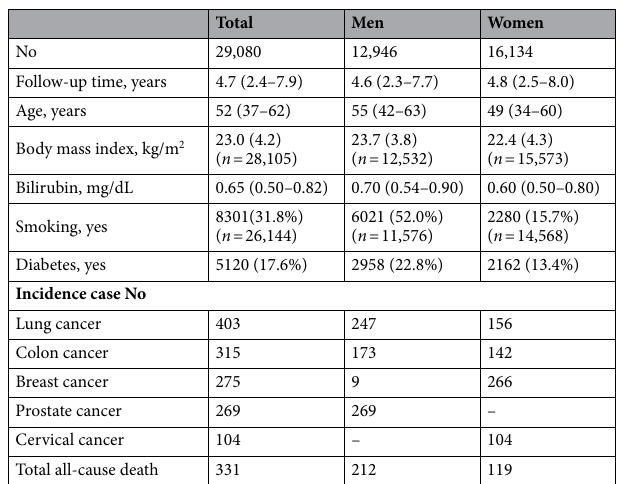
Table 1. Baseline characteristics of the study subjects. Data was expressed as median (IQR) or mean (SD). The number (No.) was expressed as absolute value and